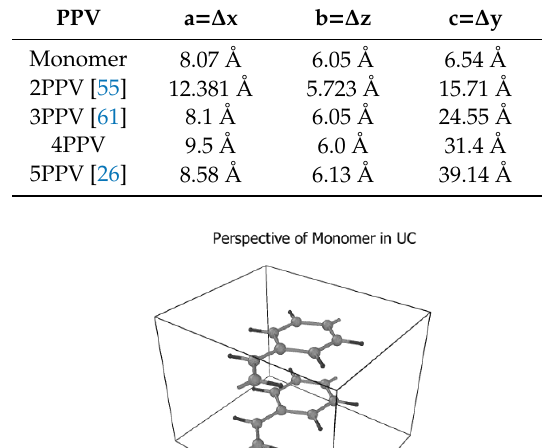
Figure 8. Reference frame and starting orientation of two PPV monomers in the simulation box. Table 4. Initial simulation cell for oligomer crystallizations.